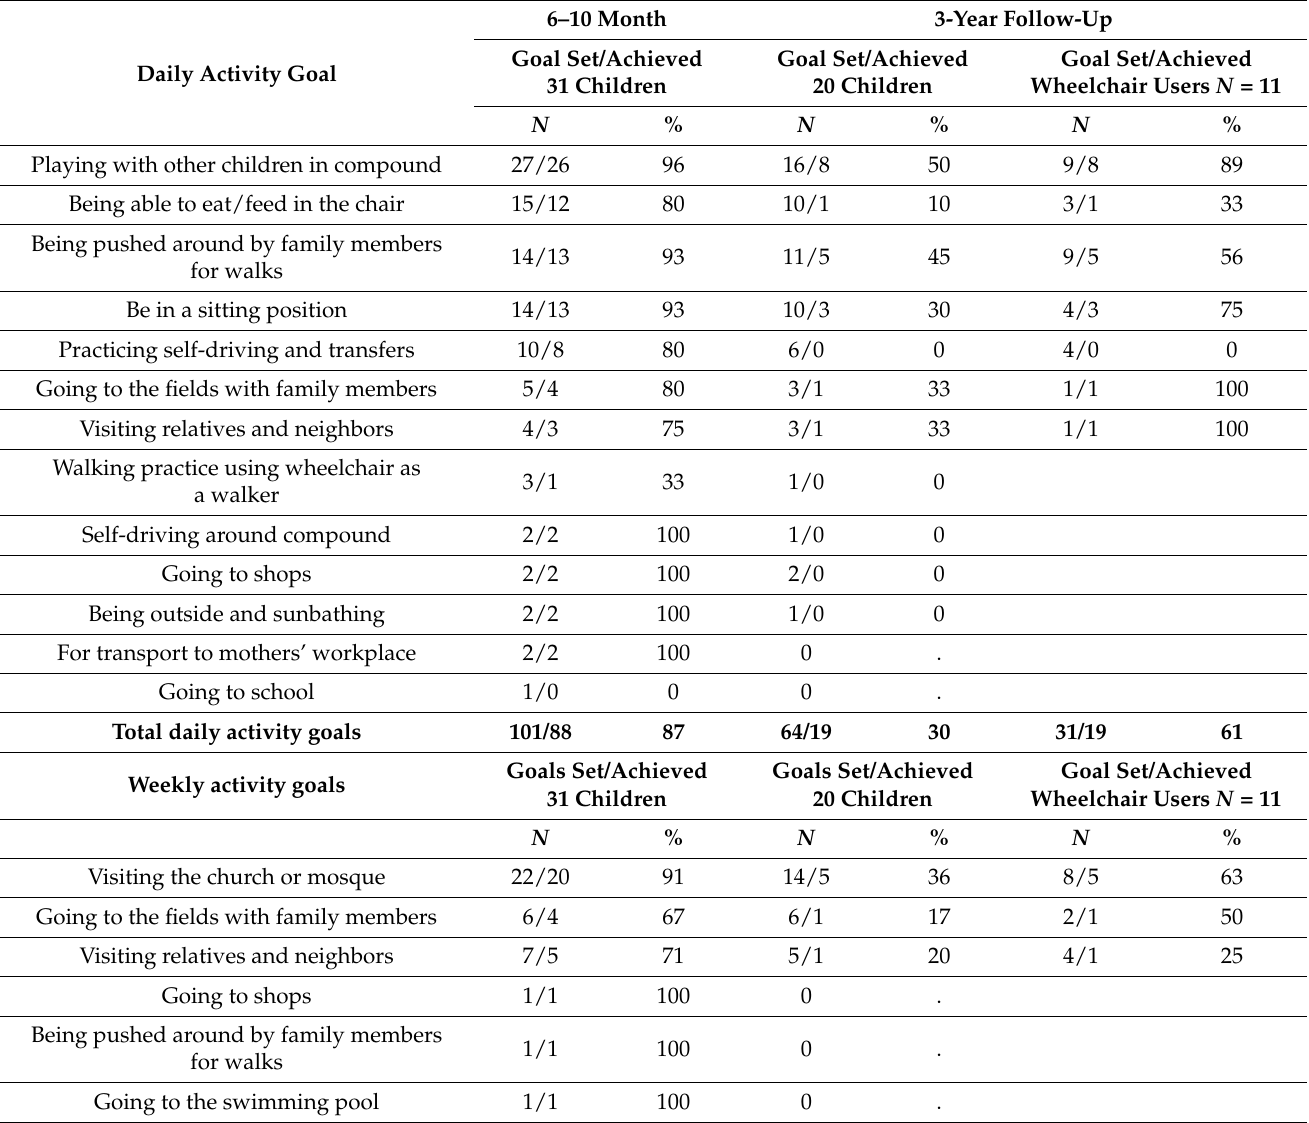
Table 2. Goals set and achieved for different areas of wheelchair use, presented for daily, weekly, monthly or few times/year at 6–10-month and 3-year follow-ups. The 3-year follow up is reported for all children possible to follow up ( N = 20) and those that used the wheelchair ( N =